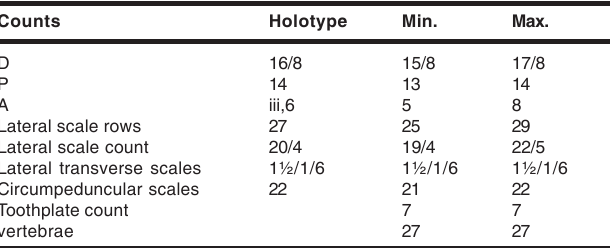
Table 3. Frequency distribution of meristic characters a. Dorsal fin counts (spines/soft rays)